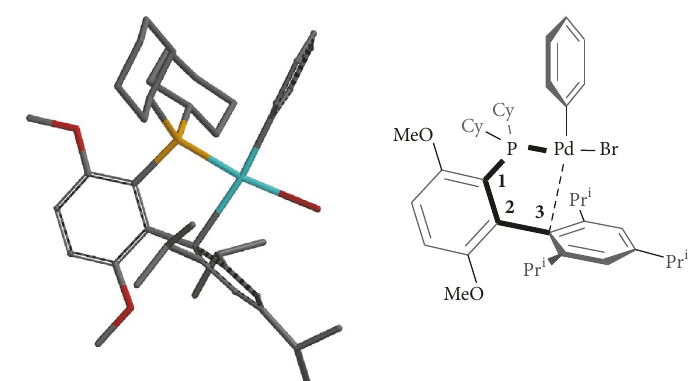
Figure 5: X-ray structure of complex VII [63].